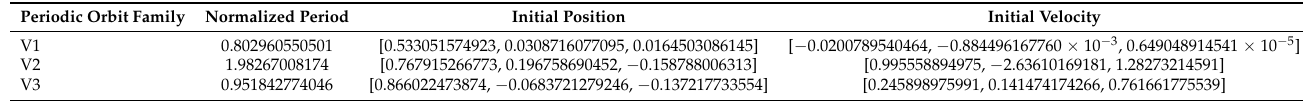
Figure 5. Periodic orbits during the continuation process of the vertical orbits family near 2867 Steins: ( a ) sample of orbits in the rotating coordinate, ( b ) variation paths of (A, B) in the plane, ( c ) the variation of period ratios during continuation, ( d ) the variation of stability index with respect to the Jacobi energy. The unit for the Jacobi energy is m 2 · s − 2 . Table 4. Initial conditions and periods of periodic orbit families near 101955 Bennu and 2867 Steins at the beginning of continuation: family V1 and V2 correspond to periodic orbits in Figures 3 and 4, family V3 corresponds to orbits in Figure 5. The data here are